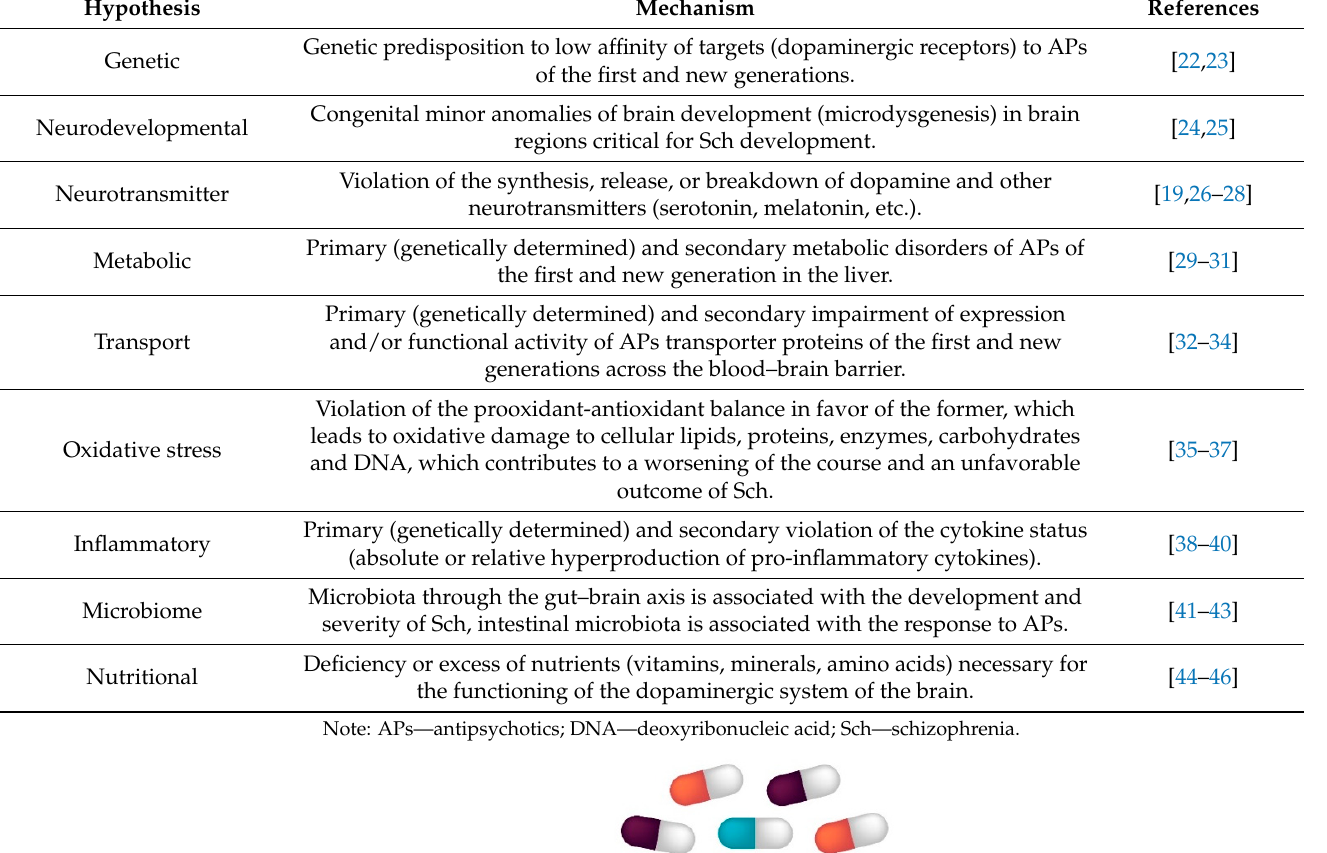
Table 1. Hypotheses for the development of treatment-resistant schizophrenia.